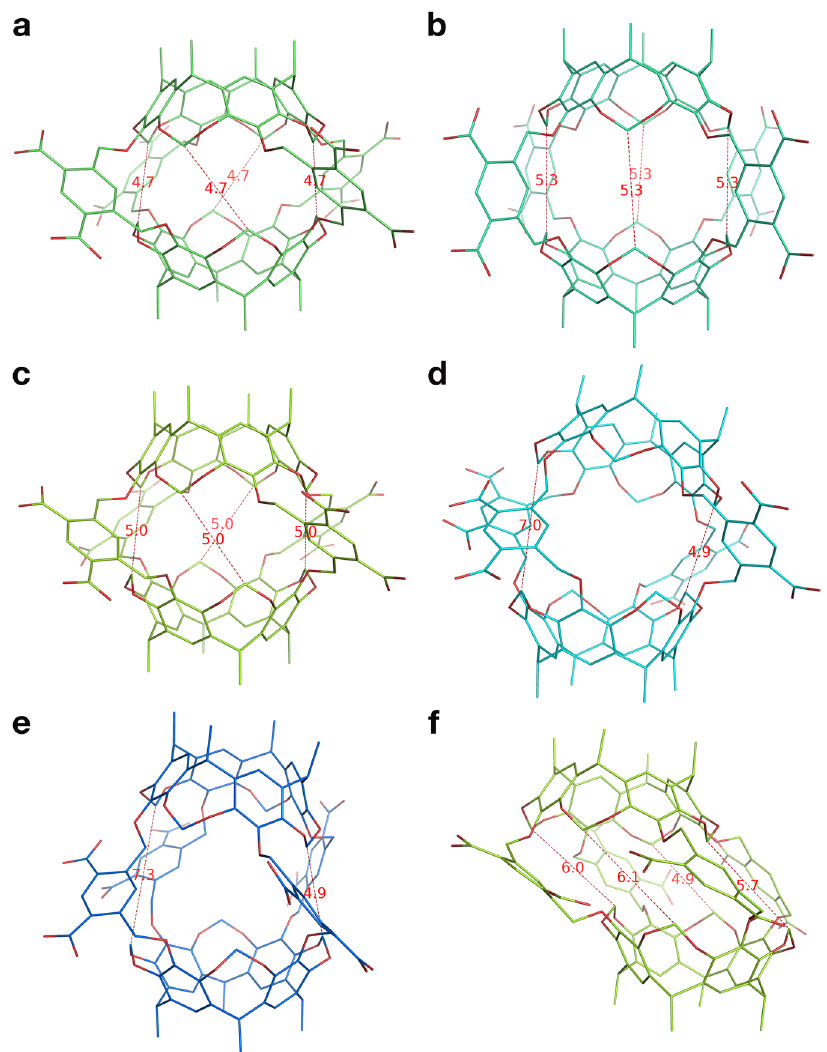
Fig. 2 Distinct conformations of Octacid4. Distances shown by thin dashed lines to indicate the open or closed equatorial portal are in Angstroms. Oxygen atoms are in red. Carbon atoms are in lime, green cyan, limon, cyan, marine, or yellow orange. Hydrogen atoms, counter ions and water molecules are not displayed for clarity. a Energy-minimization – derived Octacid4 in vacuo with all equatorial portals closed . b Energy-minimization – derived Octacid4 in vacuo with all equatorial portals open . c The most populated Octacid4 conformation with all equatorial portals closed in the aqueous MD simulations . d The second most populated Octacid4 conformation with one equatorial portal open in the aqueous MD simulations . e An Octacid4 conformation with one equatorial portal open in the aqueous MD simulations . f Another Octacid4 conformation with equatorial portals open in the aqueous MD